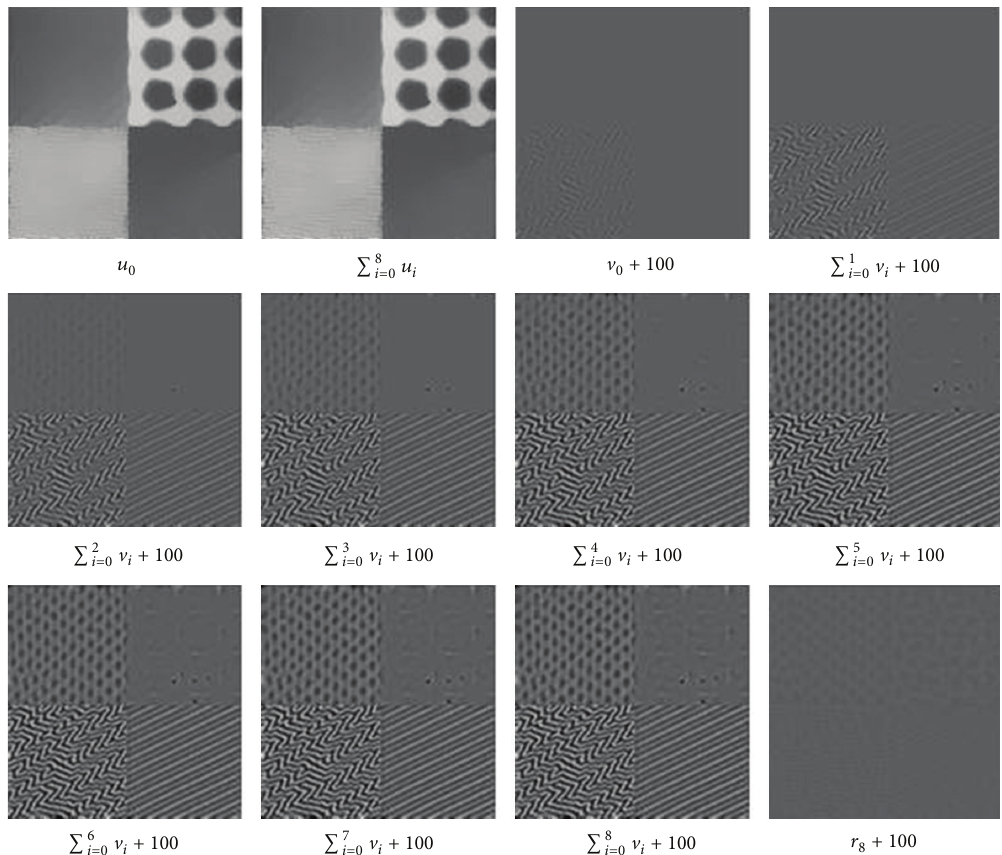
Figure 4: Multiscale texture extraction using hierarchical decomposition of a synthetic image for 9